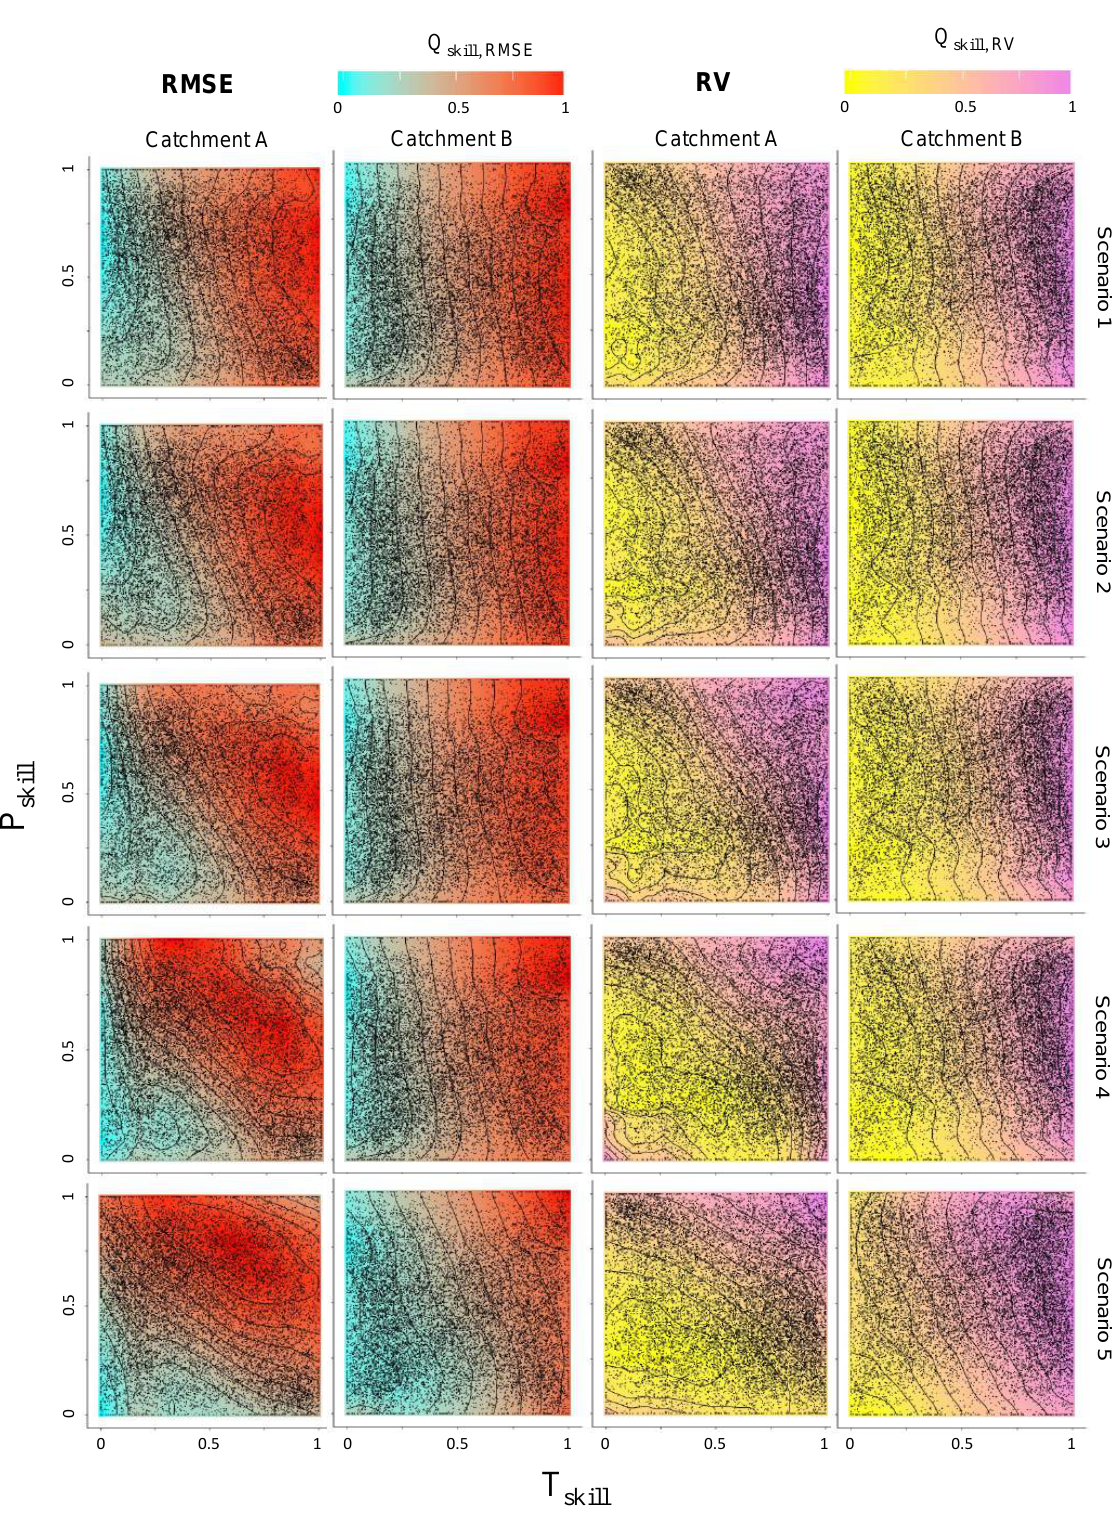
Figure 5. Relation between temperature, precipitation and runoff skill scores ( T skill , P skill , and Q skill ) for the two catchments (A and B), both skill scores (RMSE and NSE) and all Scenarios. The individual panels show the T skill and P skill calculated for all forecast blocks and lead times (150 blocks with · 108 lead times each, resulting in 16,000 combinations (black dots)), together with the mean Q skill (colors). The runoff skill scores were interpolated with a local quadratic trend surface. All results refer to the GERM